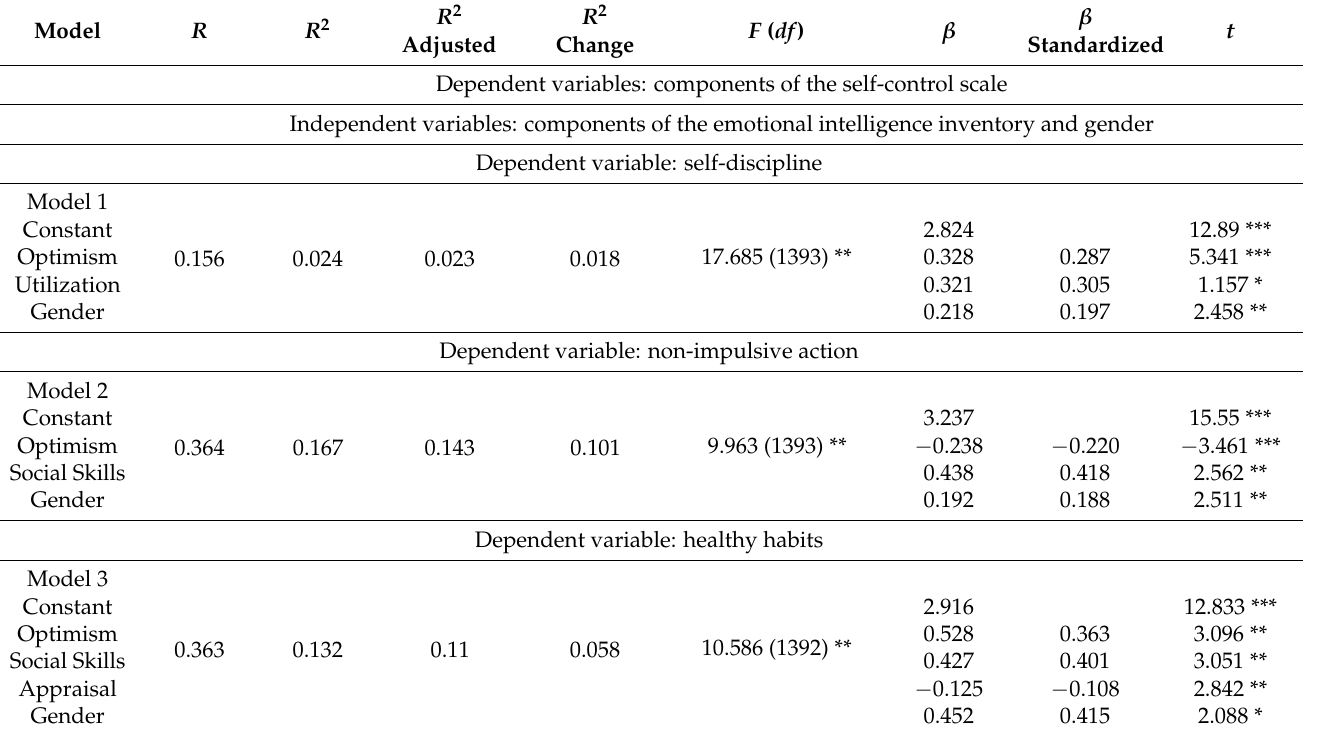
Table 3. The results of linear stepwise regression analysis of study